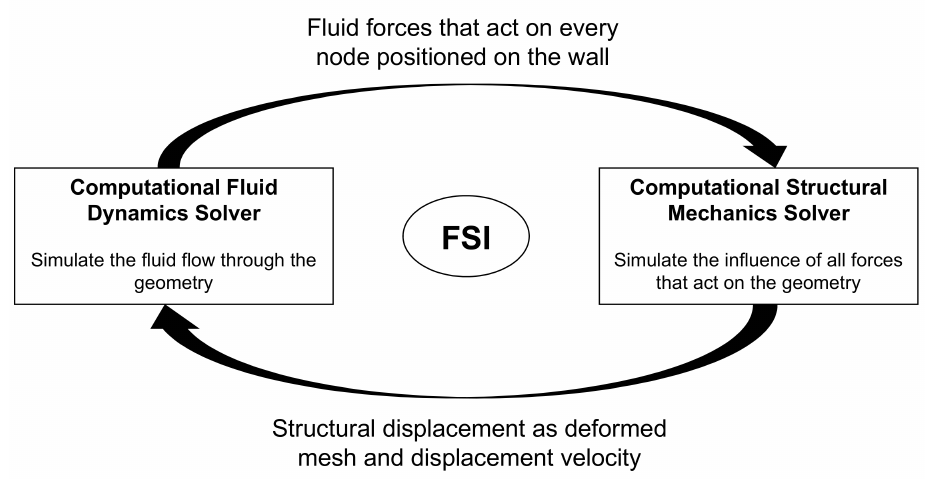
Figure 2. Segregated two-way coupled fluid structure interaction workflow.